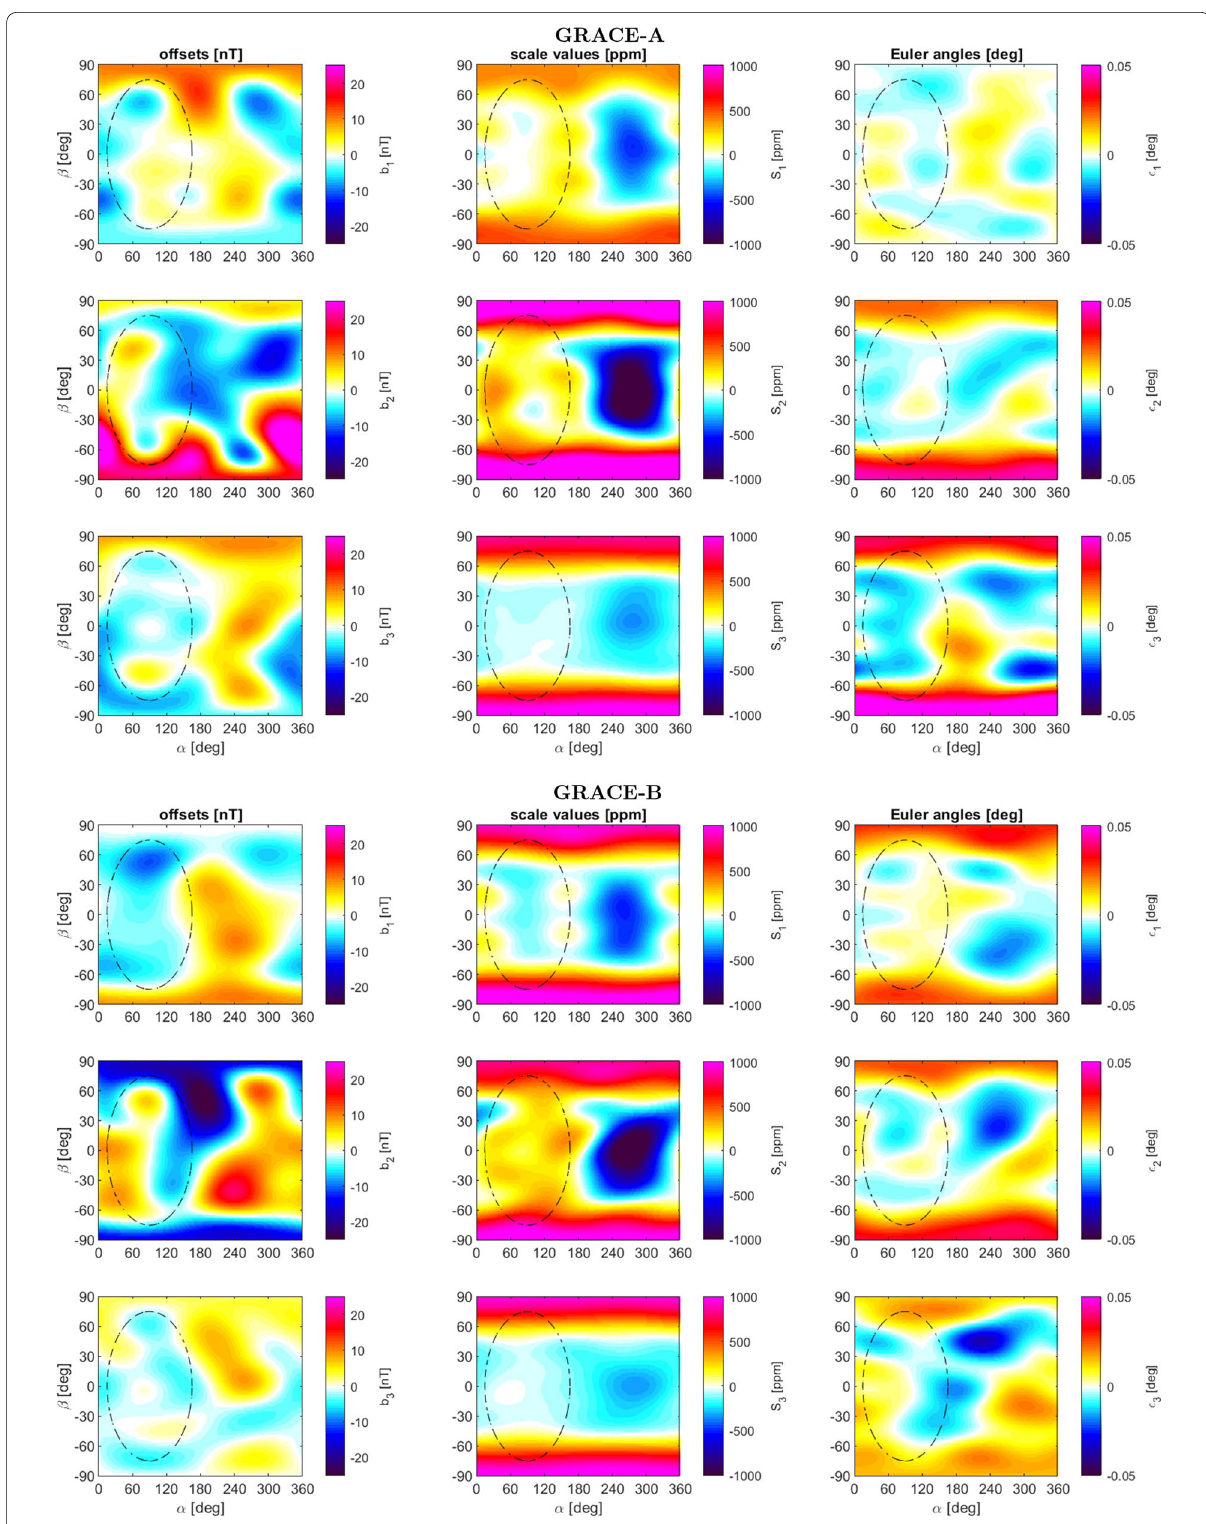
Fig. 7 Dependence of offsets, scale values and Euler angles on Sun incident angles α , β for GRACE-A (top) and GRACE-B (bottom), respectively. The dashed ellipses indicate the approximate region of the satellite being in